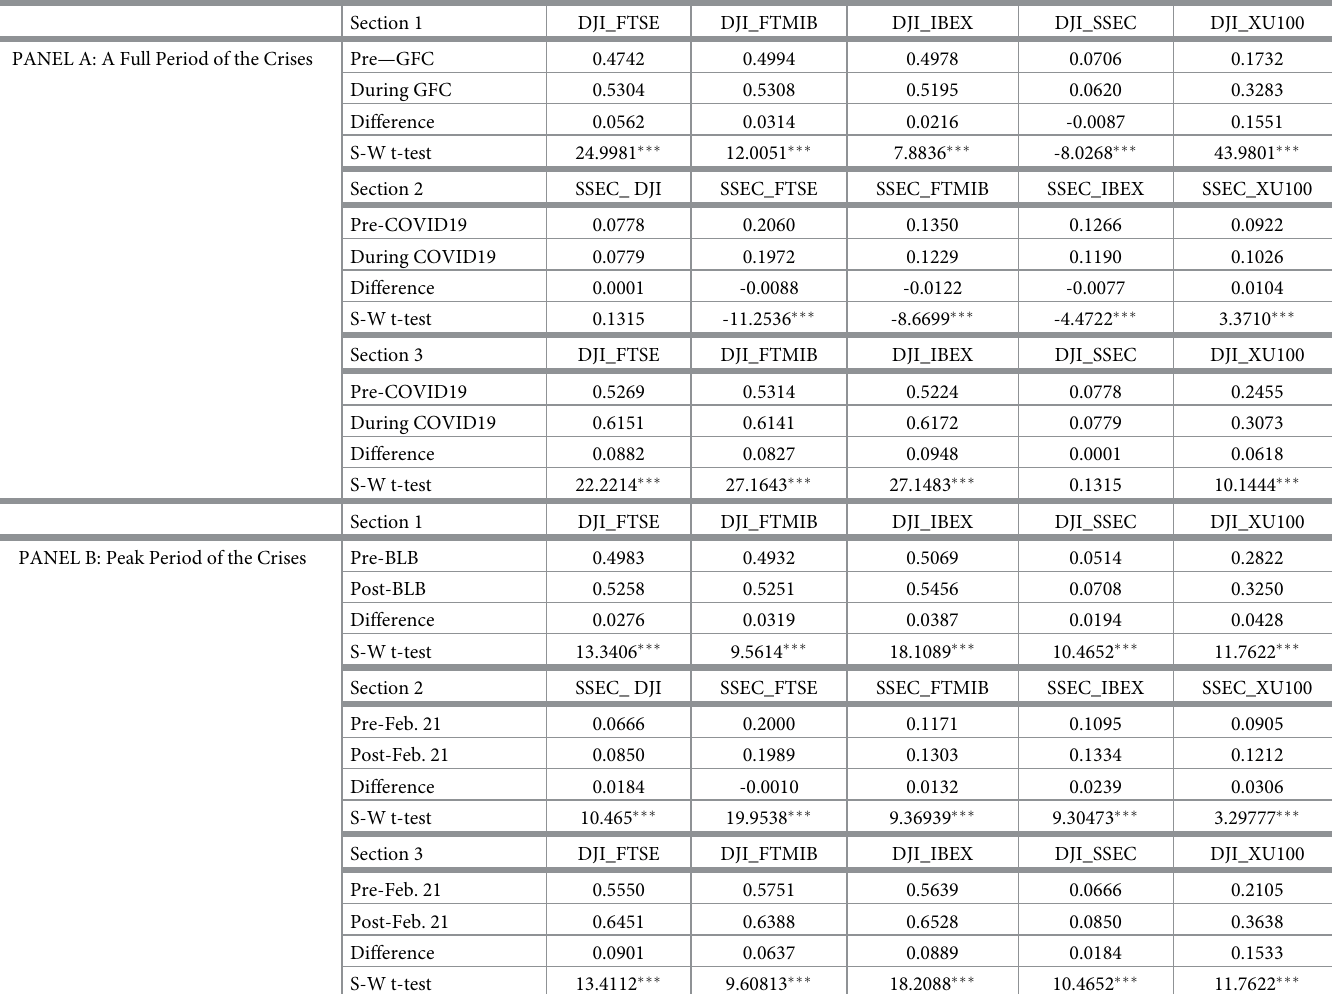
Table 5. The change in dynamic conditional correlations in crisis